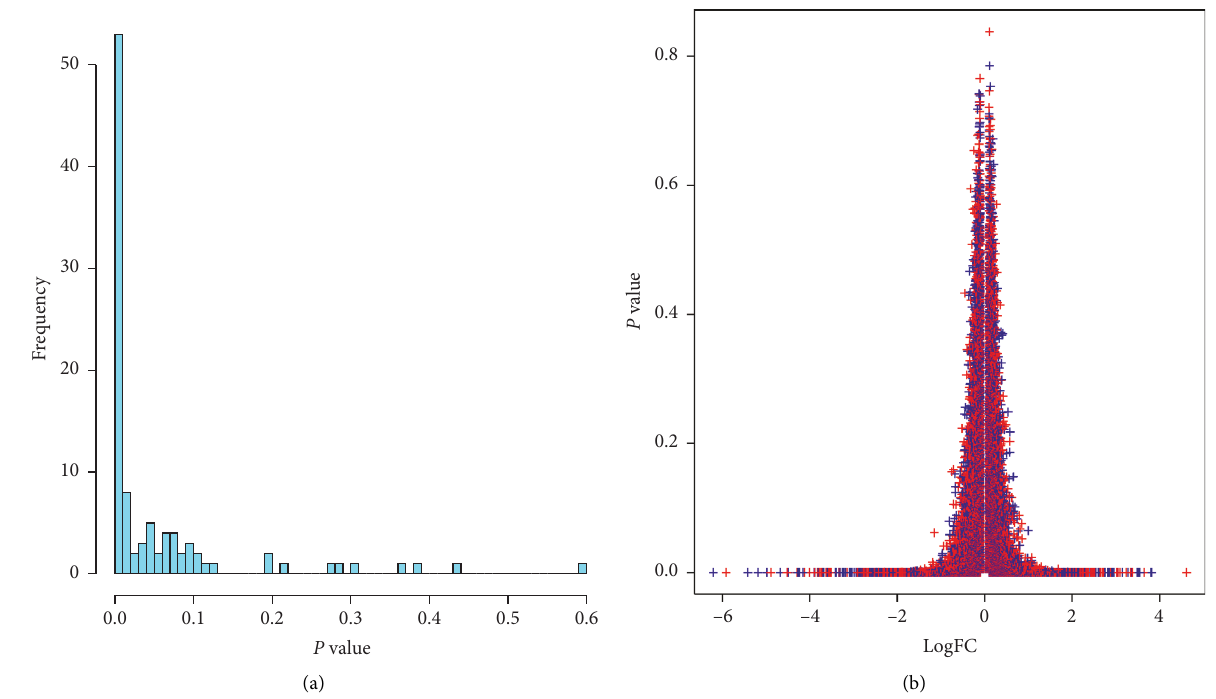
Figure 8: The genes number distribution of P < 0 . 1 and the correlation LogFC and P